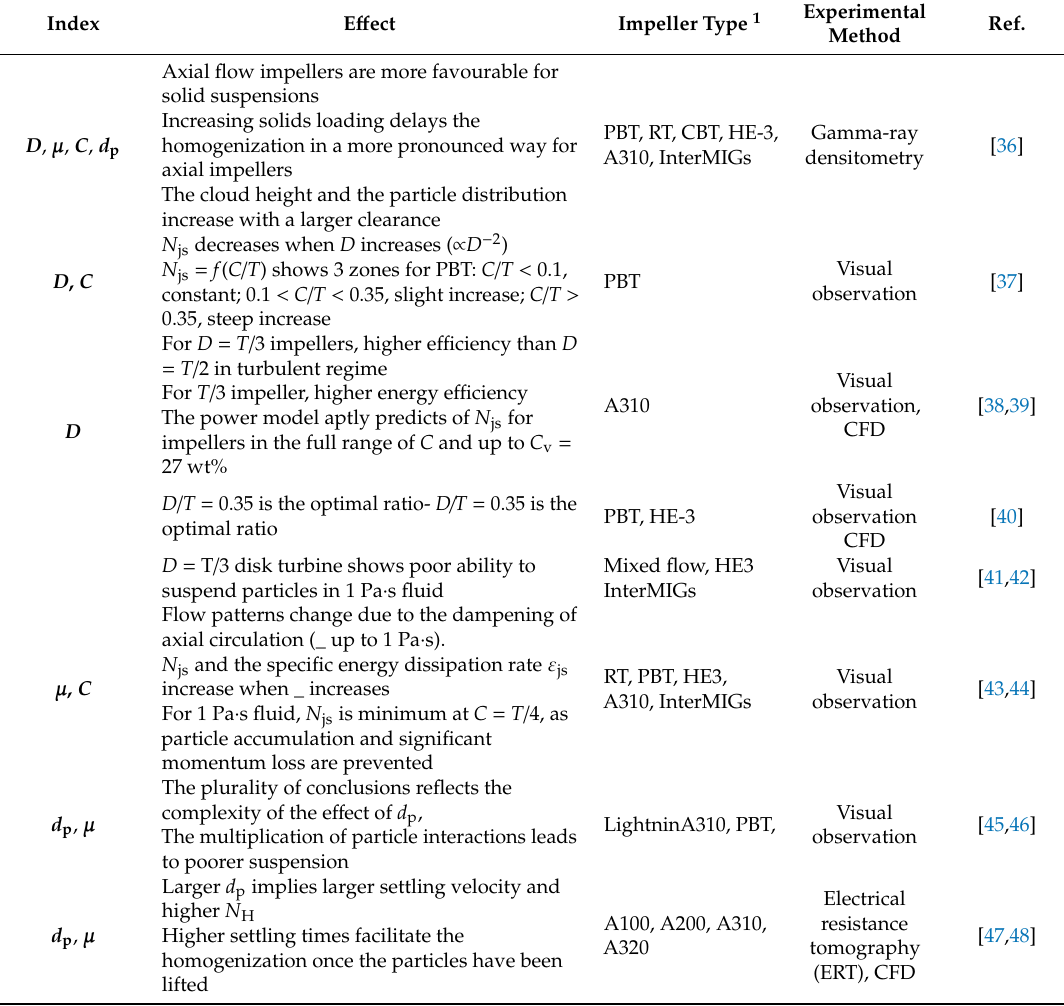
Table 1. Indexes used by various research groups to describe degrees of homogeneity suspension with impeller type, e ff ect and experimental method.